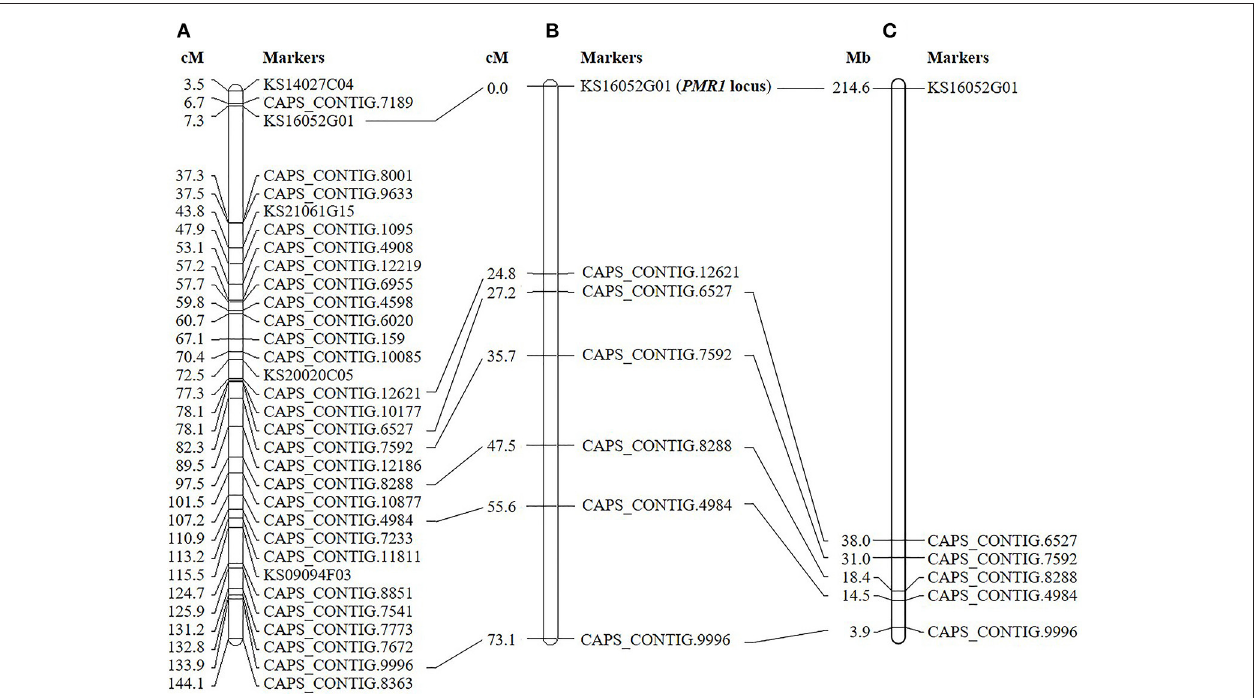
FIGURE 2 | Linkage map of the pepper PMR1 locus. (A) Genetic map of C. annuum reported by Kang et al. (2014). (B) Seven markers linked to the PMR1 locus based on the ‘VK515’ F 2 : 3 mapping population are shown. (C) Physical locations of SNP markers on ‘L_Zunla-1’ chromosome 4.